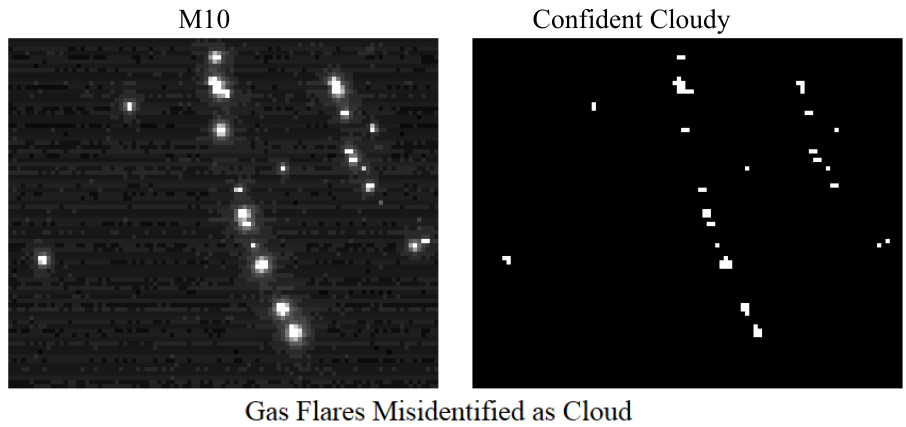
Figure 5. Gas flares often have isolated patches of cloud in the VIIRS cloud mask. M10 Confident